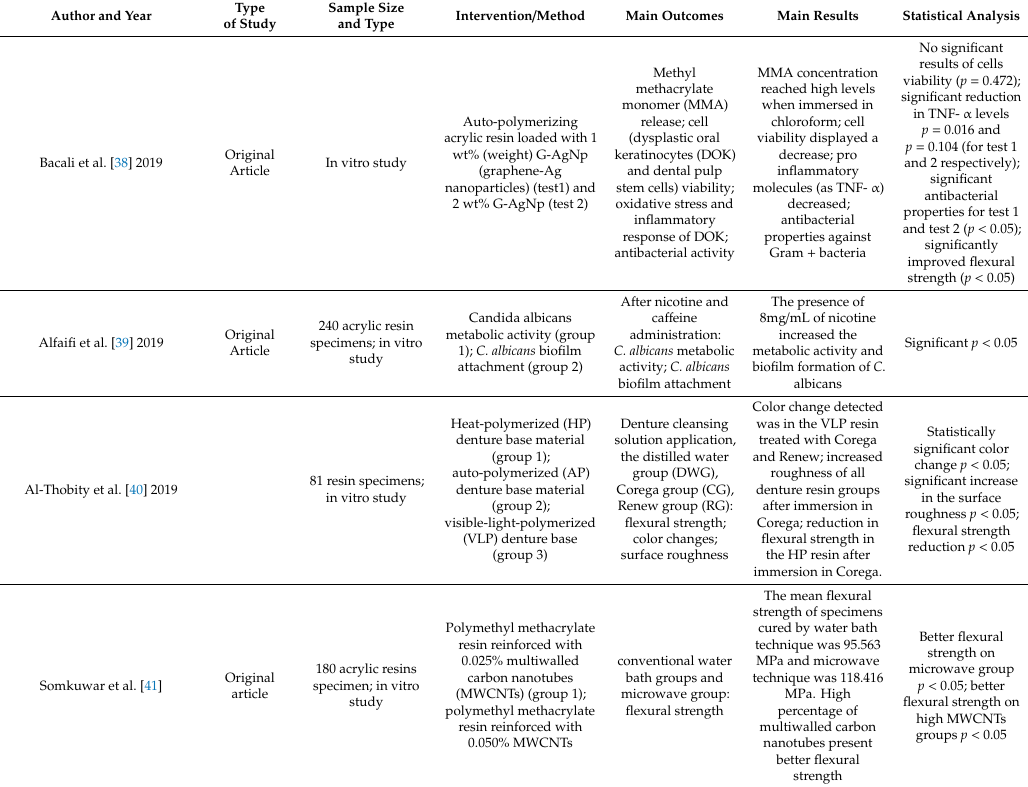
Table 1. Study main characteristics and